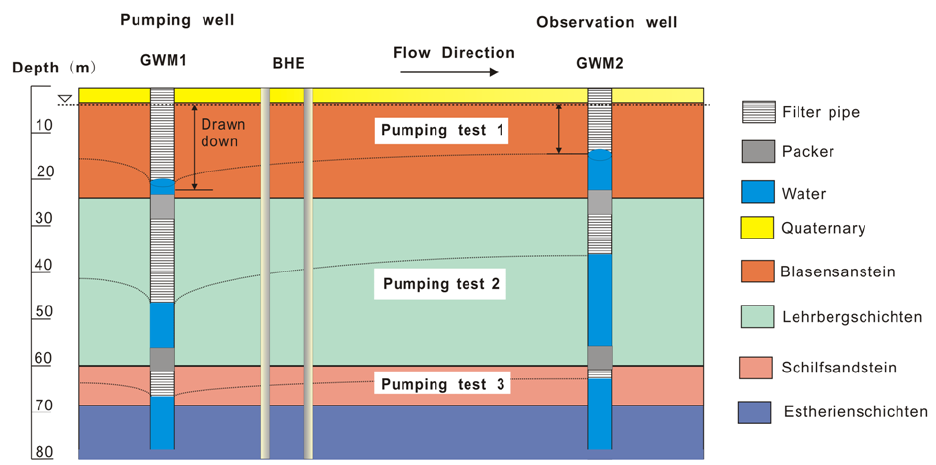
Figure 2. Schematic diagram of the pumping tests, the horizontal hydraulic properties of the geological layers have been